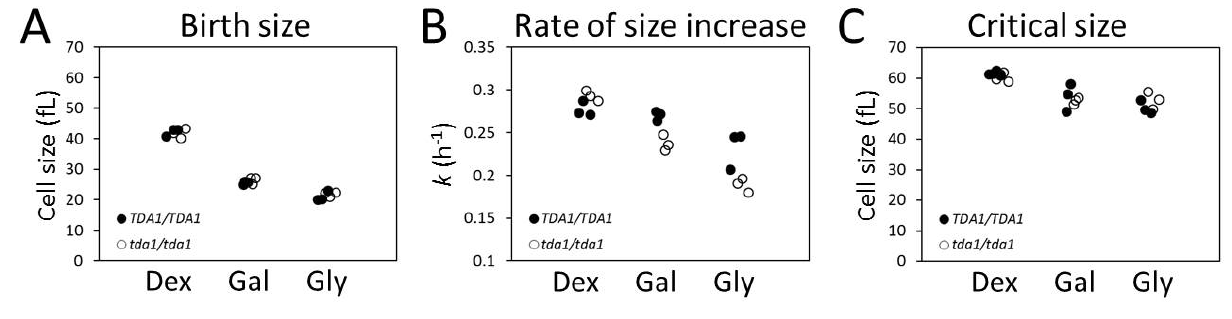
FIGURE 2: Loss of Tda1p reduces the rate of size increase but it does not affect the critical size or the birth size. (A) The birth size of tda1 ∆ /tda1 ∆ cells and their TDA1/TDA1 counterparts (in the BY4743 background) was measured from three independent experiments in each case, cultured in 1% w / v yeast extract, 2% w / v peptone and 2% w / v of either Dextrose (Dex), Galactose (Gal) or Glycerol (Gly). From syn- chronous, elutriated cultures (see Materials and Methods, and Table 1) of the same strains and media as in (A), we calculated the corre- sponding values for the specific rate of cell size increase constant k (in h -1 ) shown in (B) , and the critical size values shown in (C)